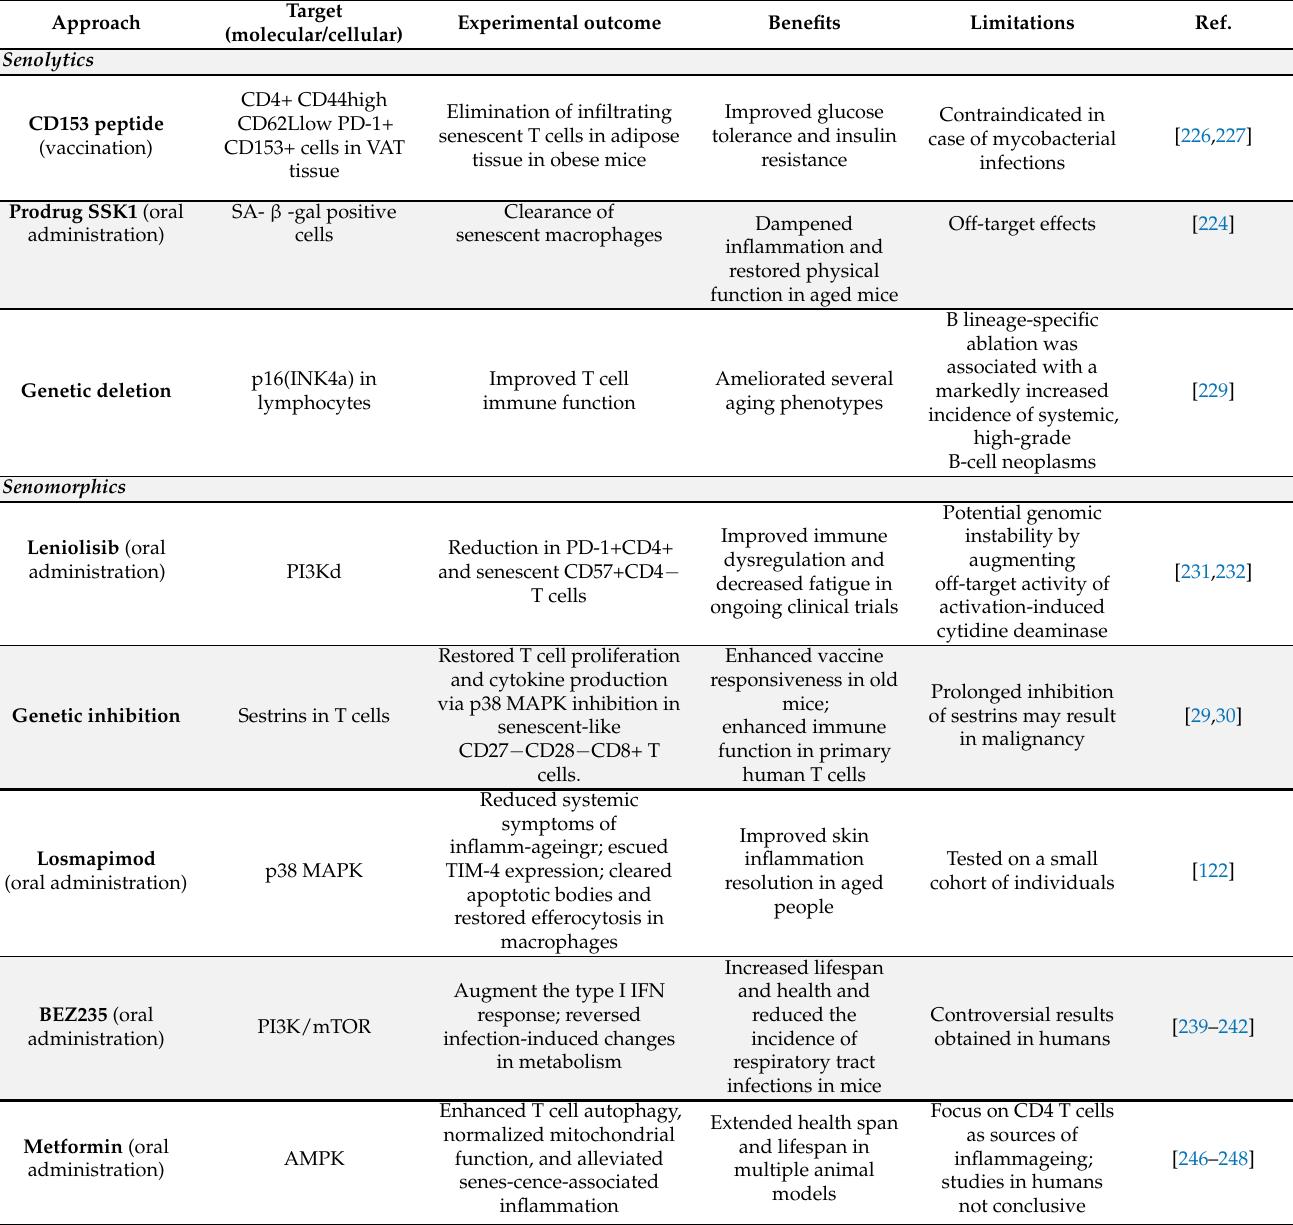
Table 1. Main potential therapeutic strategies to target senescent immune cells with implication for ageing and immunity against